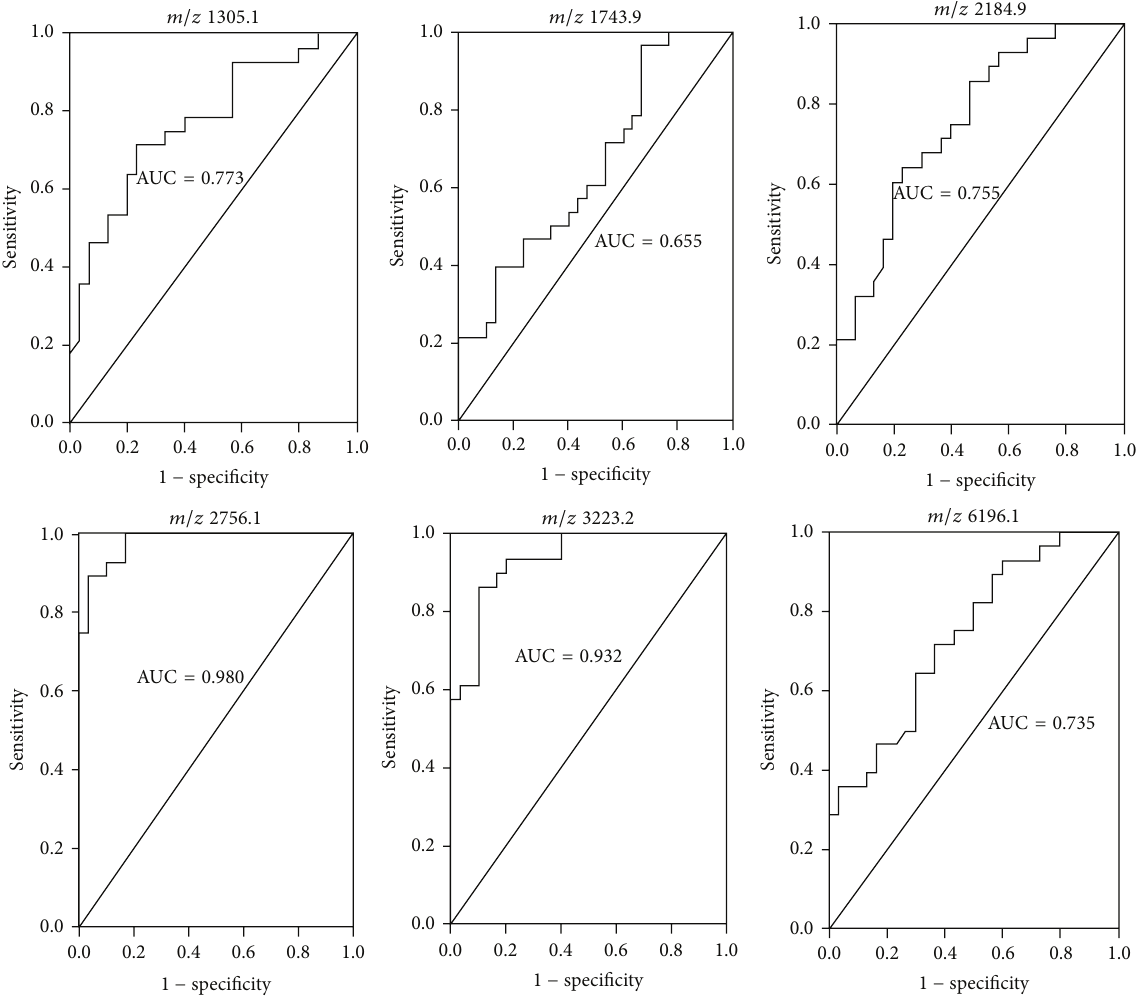
Figure 3: Receiver operator characteristics (ROC) curves generated with the m/z 1305.2, 1743.9, 2184.9, 2756.1, 3223.2, and 6196.1 used to distinguish type 2 diabetic patients coexisting with coronary artery disease from type 2 diabetic patients without coronary artery disease. The areas under the curve (AUC) were 0.773, 0.655, 0.755, 0.980, 0.932, and 0.735 for the above mentioned peaks,